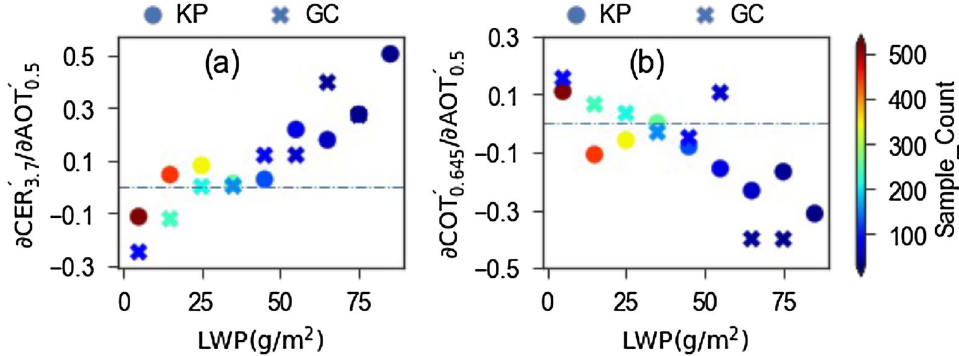
′ AOT ′ COT ′ AOT ′ 0.5 and ( b ) ∂ 0.645 /∂ 0.5 after decoupling the effects of 3.7 /∂ ′ COT ′ AOT ′ 0.645 , and 0.5 are normalized anomalies of CER at 3.7 ,